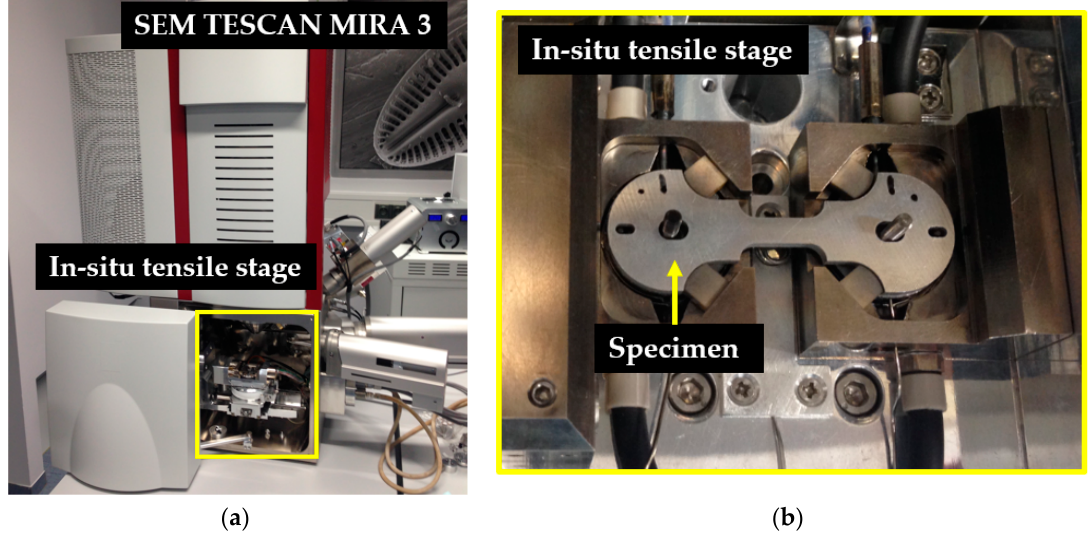
Figure 5. ( a ) SEM TESCAN MIRA 3 and in situ tensile stage MT1000 made by NewTec; ( b ) Specimen clamping in the in situ tensile stage.